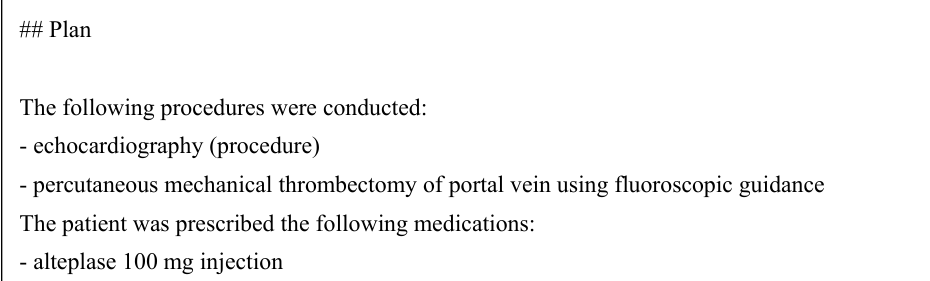
Figure A8. Clinical note from the encounter for a synthetic patient experiencing a stroke, which triggered genetic testing.